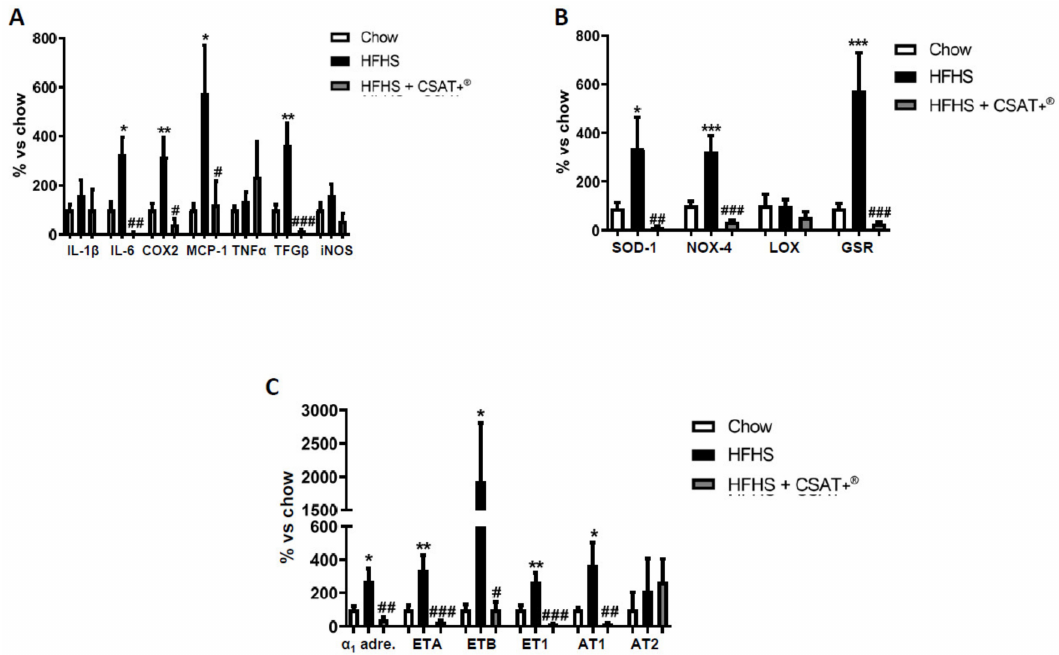
Figure 7. mRNA levels of interleukin-1 beta (IL-1 β ), interleukin-6 (IL-6), cyclooxygenase 2 (COX2), monocyte chemoattractant protein (MCP-1), tumor necrosis factor-alpha (TNF α ), transforming growth factor beta (TGF β ) and inducible nitric oxide synthase (iNOS) ( A ), superoxide dismutase-1 (SOD-1), NADPH oxidase-4 (NOX-4), lysyl oxidase (LOX) and glutathione reductase (GSR) ( B ) and alpha-1 adrenergic receptor ( α 1 adre), endothelin receptor type A (ETA), endothelin receptor type B (ETB), endothelin-1 (ET-1), angiotensin receptor type 1 (AT1) and angiotensin receptor type 2 ( C ) in aortic tissue of mice fed a standard diet (Chow), a high fat diet / sucrose diet (HFHS), or high fat diet / sucrose diet supplemented with the carob pod extract (HFHS + CSAT + ® ). * p < 0.05; ** p < 0.01; *** p < 0.001 vs. chow. # p < 0.05; ## p < 0.01; ### p < 0.01 vs. HFHS. Values are represented as mean ± S.E.M; n = 8 samples / experimental